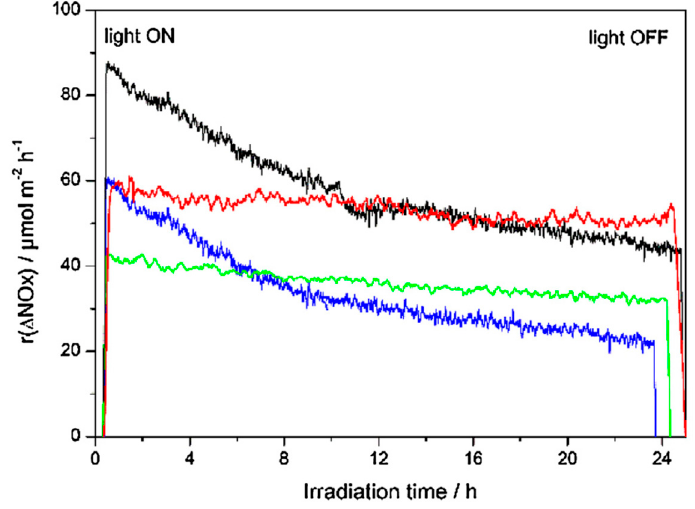
Figure 38. Comparison of the photocatalytic reaction rates in the degradation of NO x with the FN2 and P-25 in both ideally-mixed and laminar flow reactors for an inlet NO 2 concentration of 0.1 ppmv and relative humidity (RH) of 50%. FN2 (black) and P-25 (blue) coated on concrete in laminar flow reactor. FN2 (red) and P25 (green) coated on plaster in ideally-mixed flow reactor. Reproduced with permission from Zouzelka and Rathousky [128]. Copyright 2017 by The Authors (open access license).